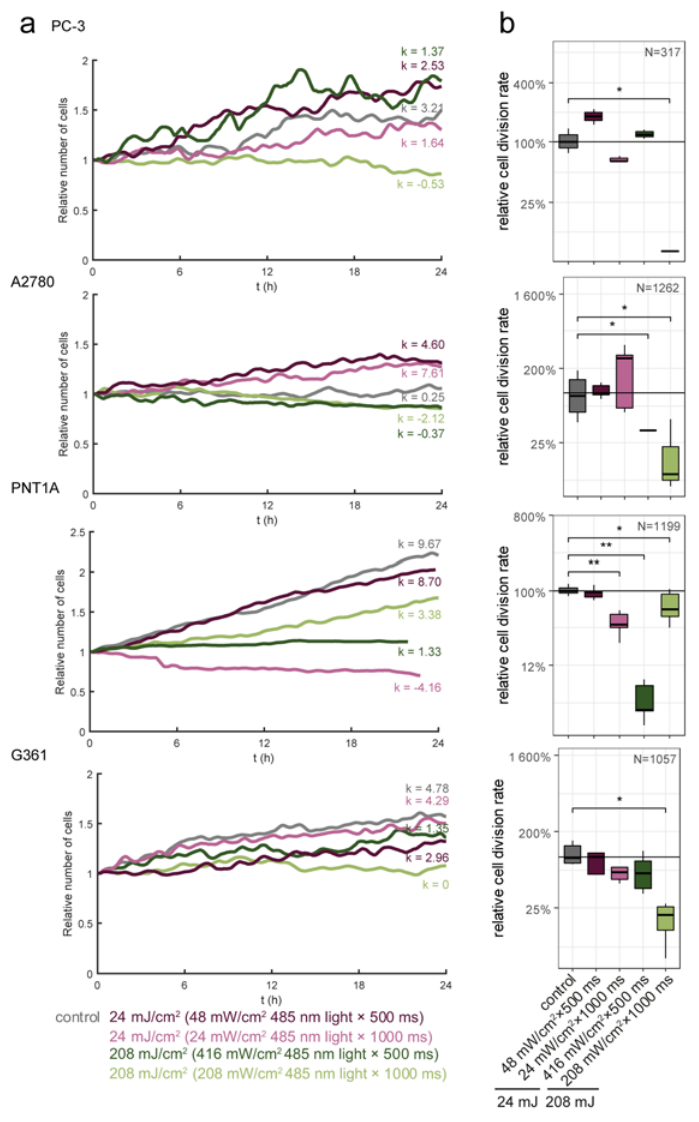
Figure 4. Cell numbers and cell division rate of cells affected by different doses of blue light. ( a ) Real-time QPI-measured changes in cell numbers of PC-3, A2780, PNT1A, and G361 cells during 24 h of the experiment. Lines are shown as the mean and standard error. K value means the slope of the least-square fitted line (increment of the value per hour). ( b ) Cell division rate relative to the division rate of control cells. * indicate p < 0.05, ** p < 0.01 by Wilcoxon test. The number of cells (N) shown for all treatments in a timepoint 0.